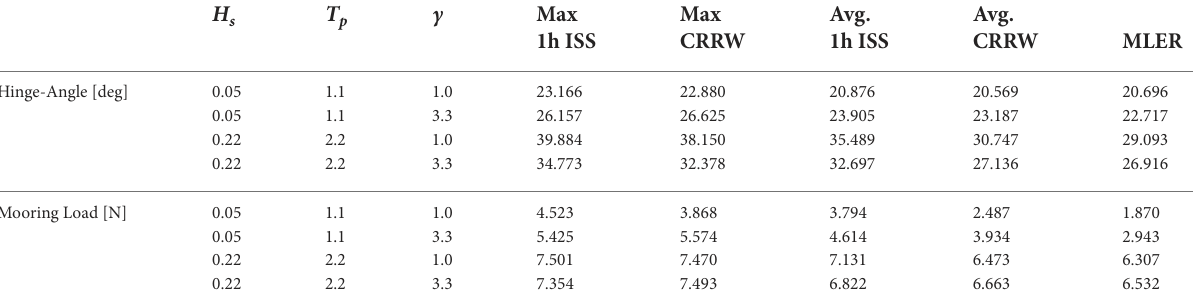
TABLE 3 Largestandaverage“maximumresponse”fortheirregularseastatesandCRRWruns.ThemaximumresponsevaluesfortheMLERarealso